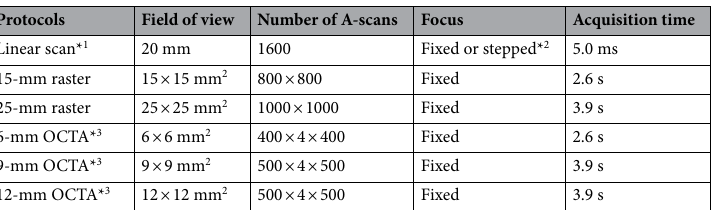
Table 2. OCT and OCTA scan protocols used in this study. The order of the A-scan numbers is: [Number of A-scans per B-scan] × [Number of B-scan repeats (OCTA only)] × [Number of B-scan locations per volume (volumetric scans only)]. * 1 Multiple linear scans can be repeated, arranged in a radial scan pattern, or a combination. * 2 The focal plane can be kept constant, or stepped, i.e. from the anterior corneal surface to the posterior surface of the lens capsule, between successive linear scans. * 3 Structural OCT can also be generated by simple averaging of repeated B-scans in order to improve